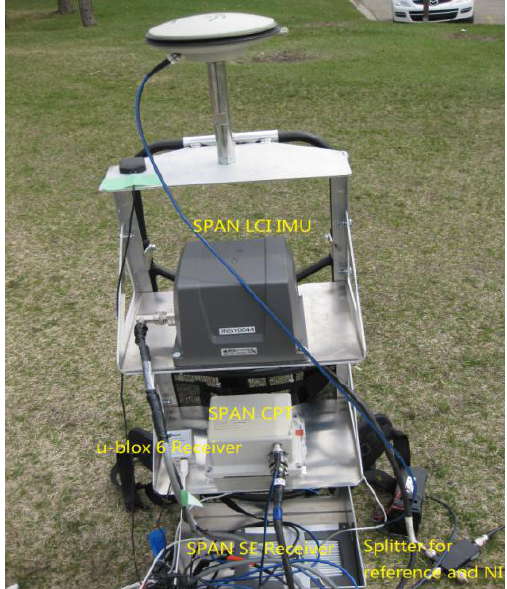
Figure 5. Primary equipments used in data collection. SPAN TM LCI IMU, CPT, and SPAN TM receivers are shown on the left; NI front-end is shown on the